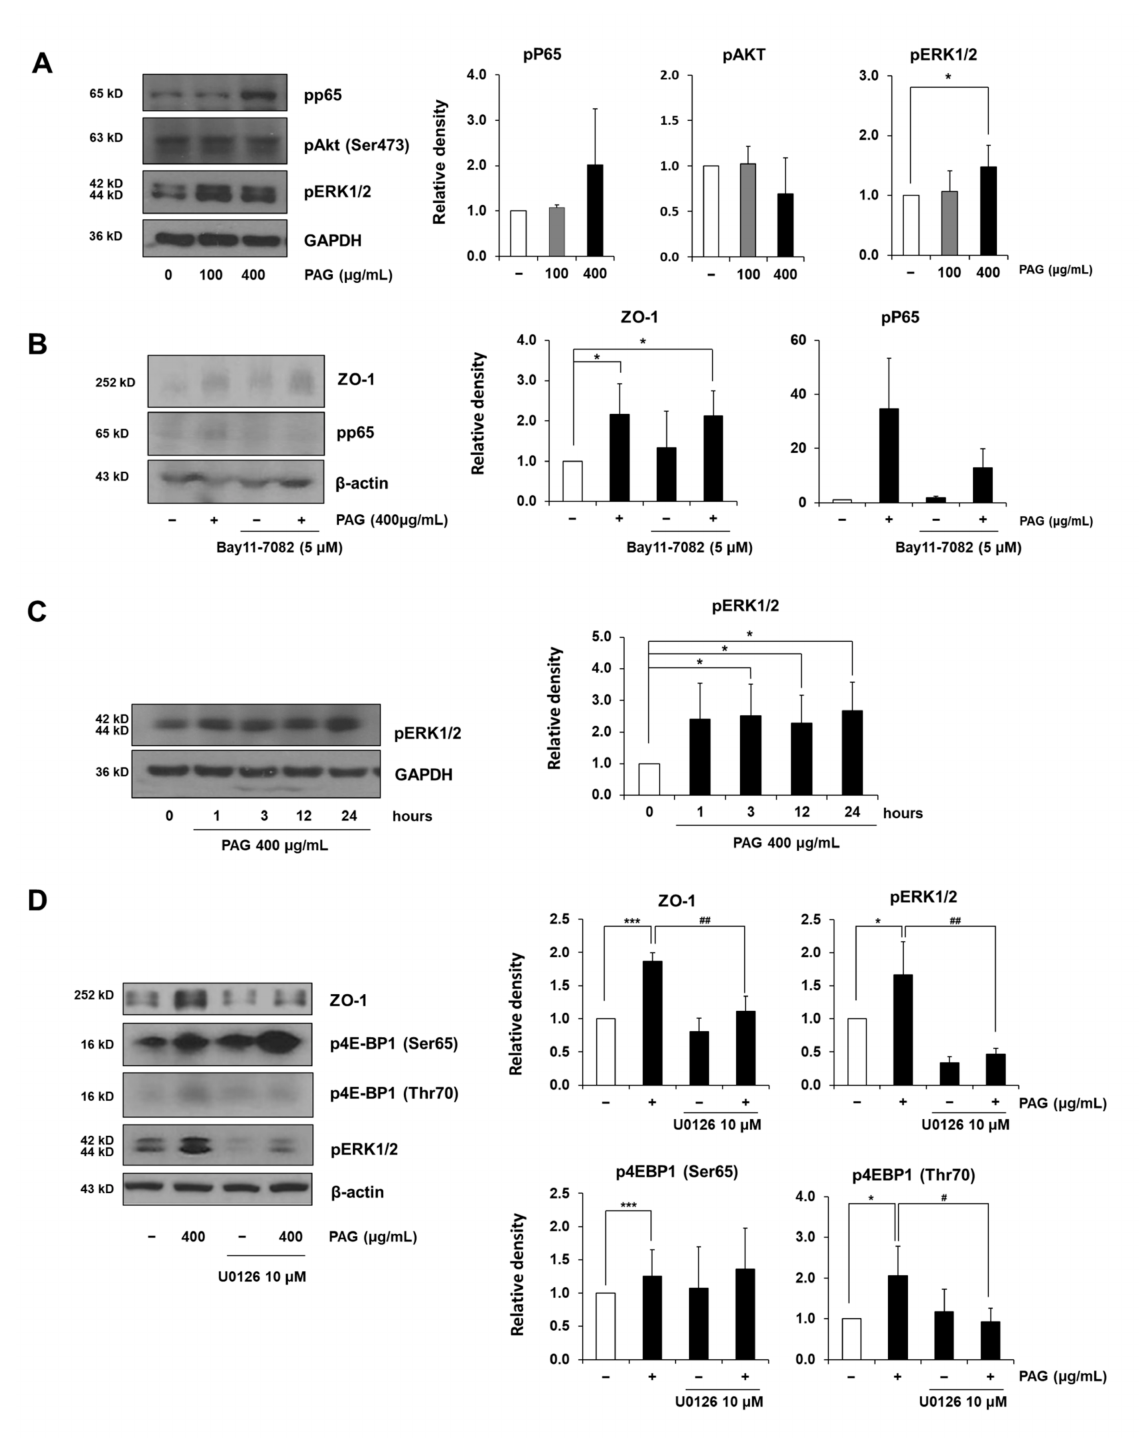
Figure 4. PAG increases expression level of ZO-1 via activating MAPK/ERK signaling pathway. ( A ) Caco-2 monolayers were treated with PAG to investigate different tight junction-related signaling pathways; ( B ) NF- κ B inhibitor BAY11-7082 was employed to investigate the association between NF- κ B/P65 and ZO-1 expression levels in Caco-2 cells under 48-h PAG treatment; ( C ) Caco-2 treated with PAG showed increased phosphorylated MAPK/ERK, in a pattern similar to phosphorylation of 4E-BP1; ( D ) Caco-2 monolayers were pre-treated with or without MAPK inhibitor U0126 10 µ M along with exposure to PAG for 48-h, to determine the relation between MAPK/ERK, 4E-BP1, and ZO-1 expression levels. Values are presented as mean ± standard deviation (Student t -test was applied for statistical analysis; *, # p < 0.05; ## p < 0.01; *** p <